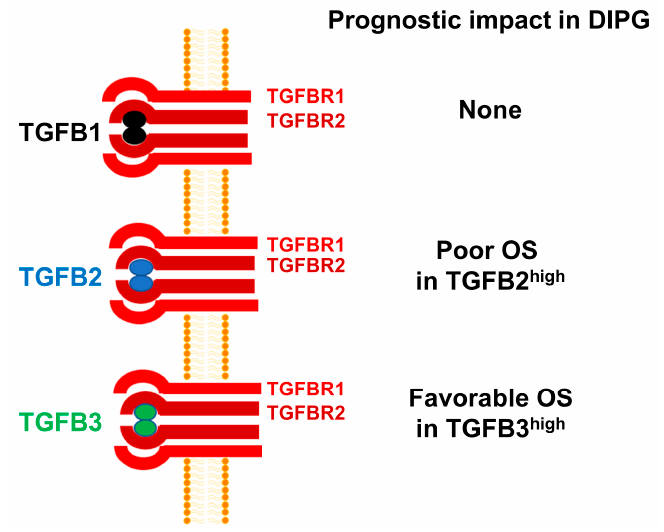
Figure 7. TGFB2 mRNA expression is selectively amplified and associated with poor OS in pediatric DIPG. mRNA levels for TGFB2 were selectively amplified in primary brain tumor specimens from DIPG patients, whereas the mRNA levels for TGFB1 and TGFB3 were not. High levels of TGFB2 mRNA expression was associated with poor OS. By contrast, high TGFB1 mRNA expression had no prognostic value and high TGFB3 mRNA expression was associated with favorable OS.